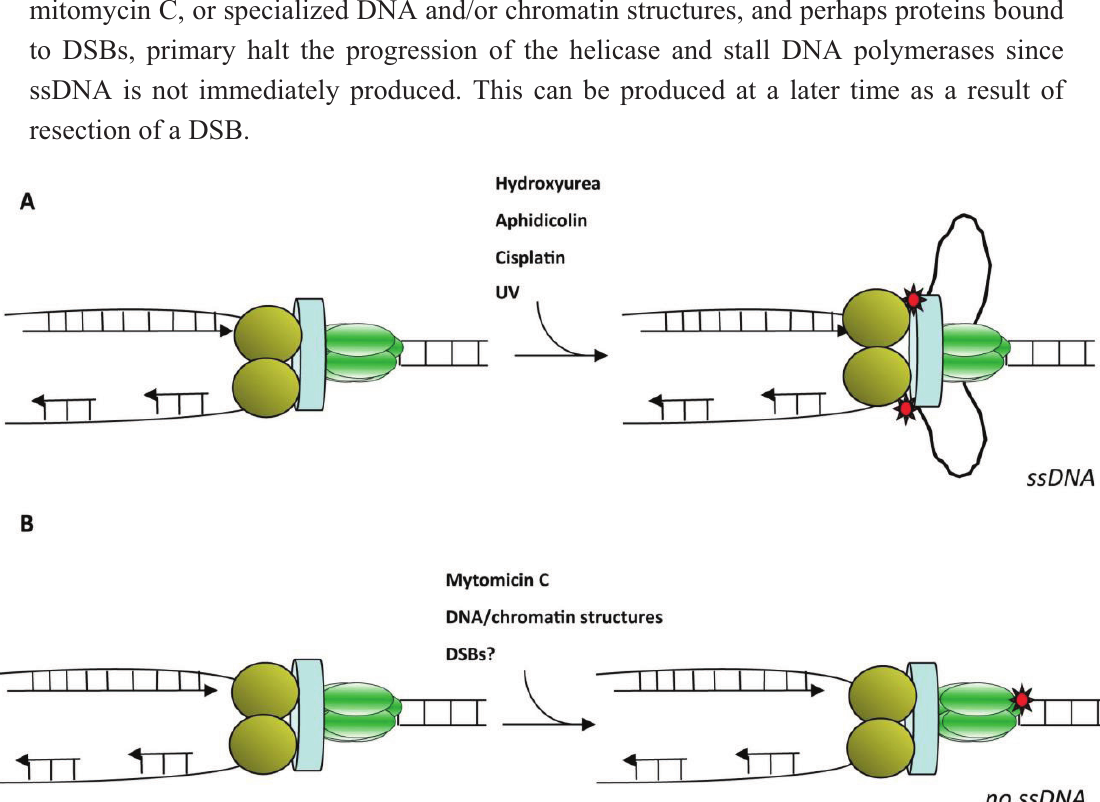
Figure 3. Schematic representation of two different types of replication